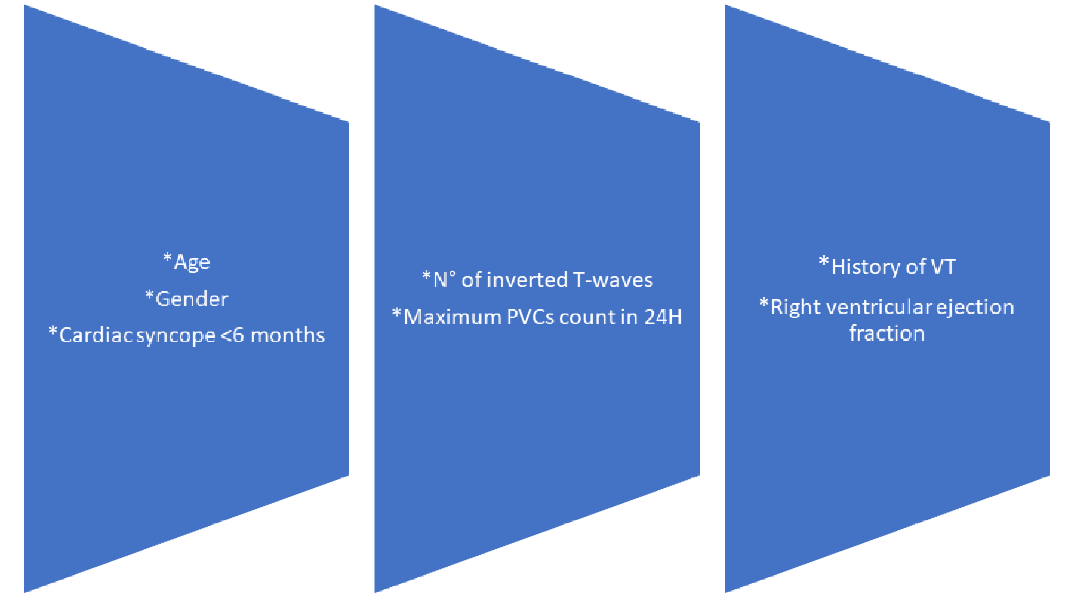
Figure 1. Arrhythmogenic cardiomyopathy sudden death risk calculator. Adapted from ARVC risk. N ◦ : number, PVCs: premature ventricular complex, H: hours, VT: Ventricular